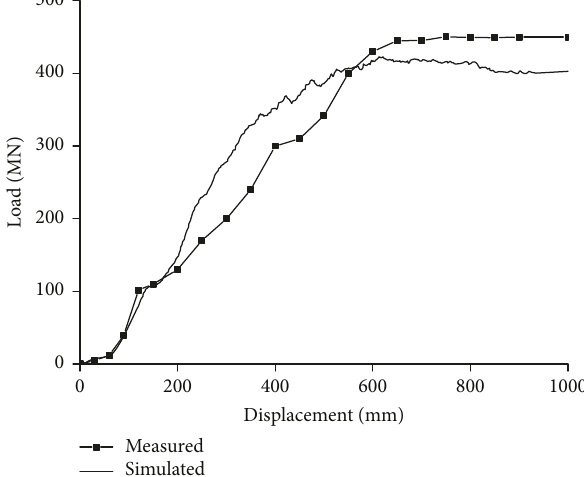
Measured Simulated Figure 19: The comparisons between measured and simulated displacement—load